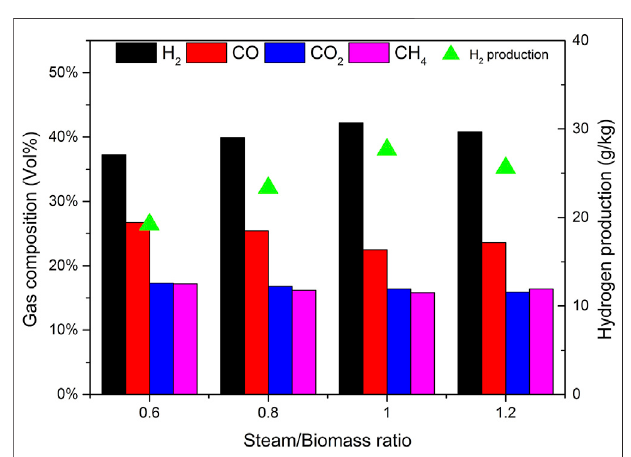
FIGURE 13 | Effect of SBR on gas composition and hydrogen